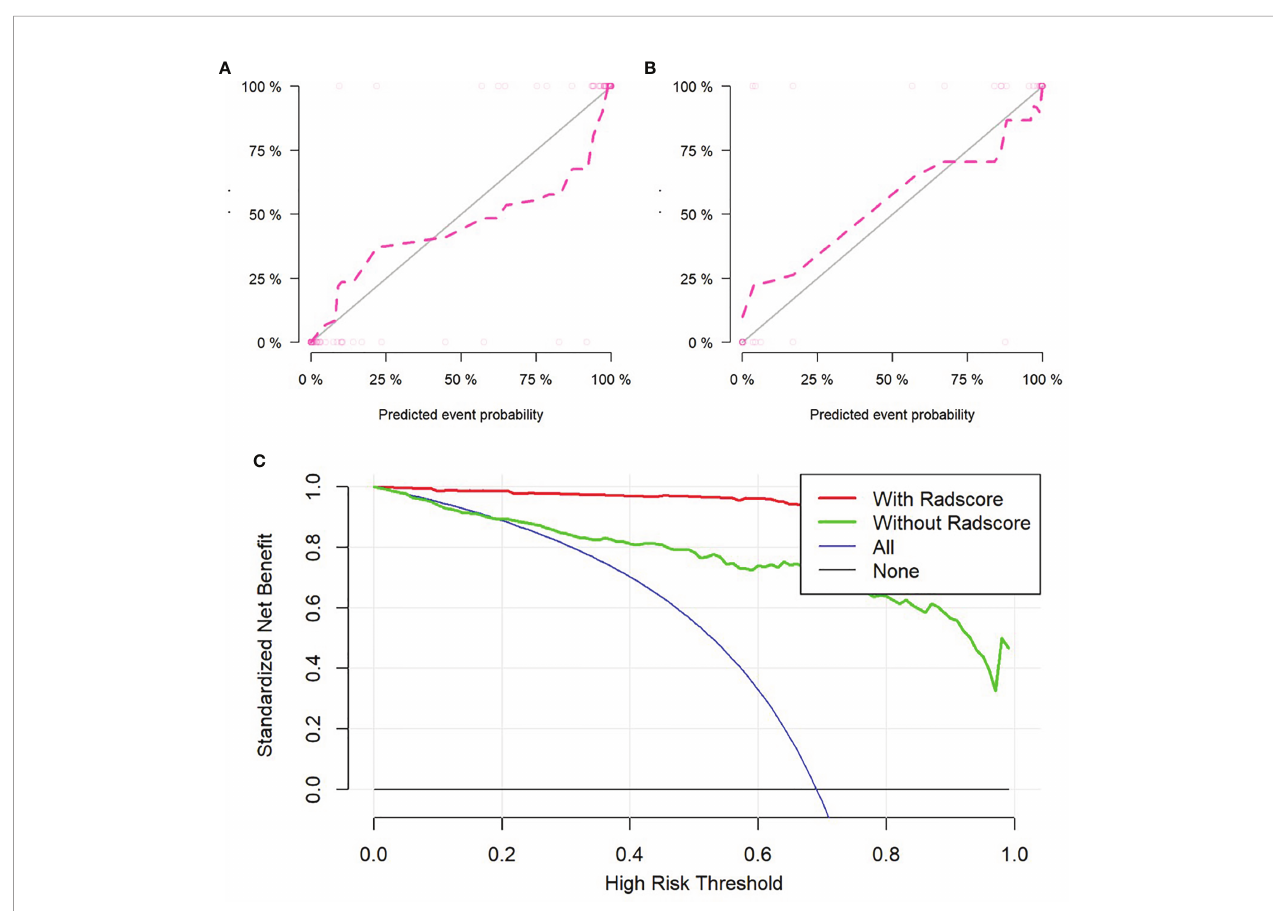
FIGURE 5 | Validation of radiomics nomogram, the calibration curves of radiomics nomogram in training set (A) and validation set (B) . Decision curve analysis for radiomics and clinical model to evaluate the clinical usefulness of the model (C)